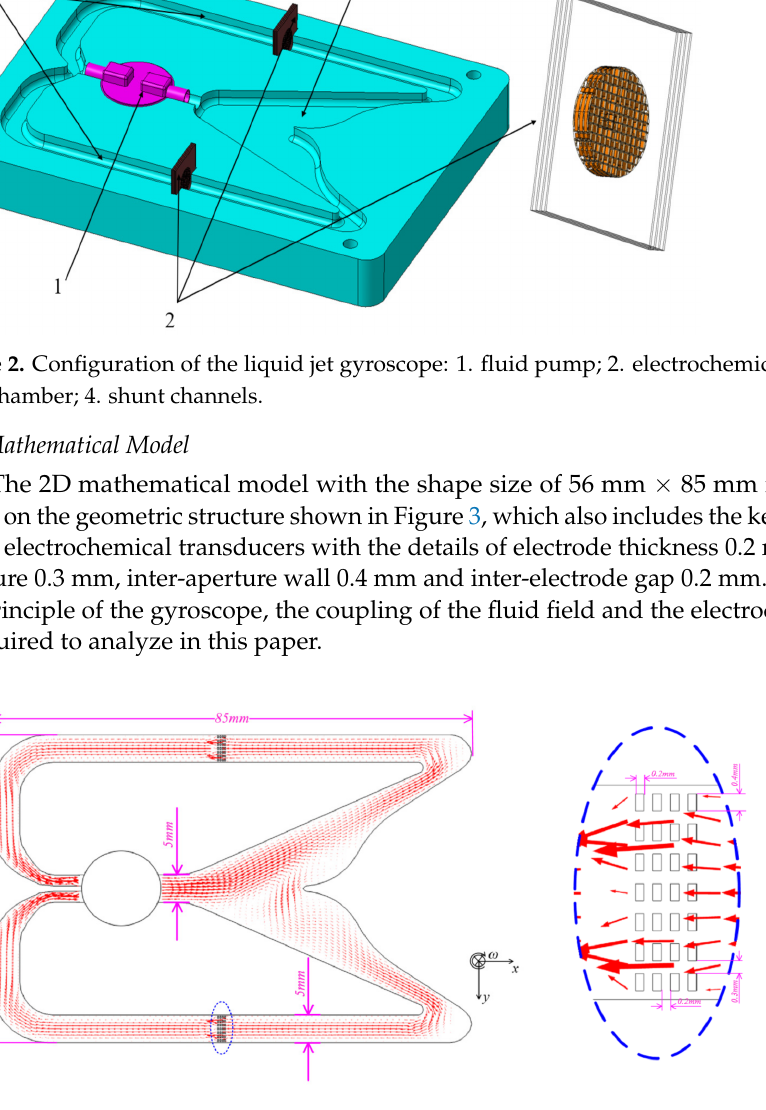
Figure 3. Schematic diagram of the liquid jet gyroscope. The jet flow velocity and direction are shown by the size and direction of red